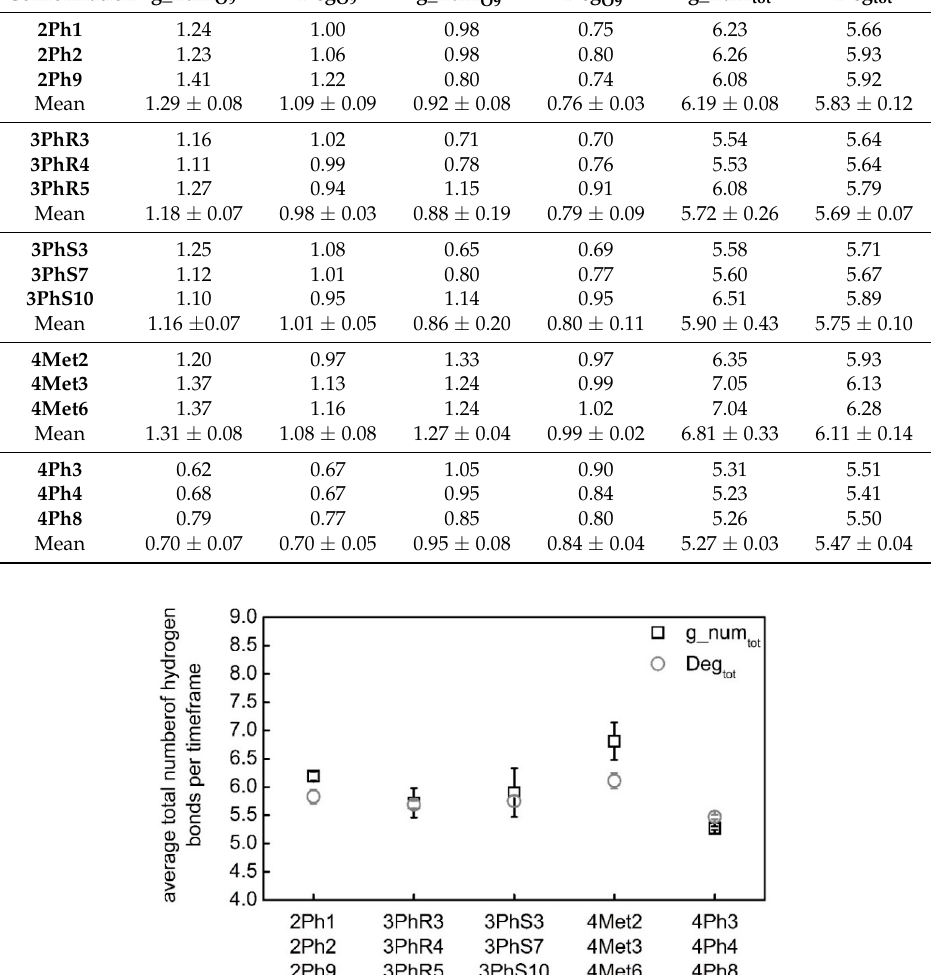
Table 2. The average number of hydrogen bonds per timeframe (Gromacs) compared to the average hydrogen bond degree between TIP4P water and the sites of interest in the LIGNOLs ( ChemNetworks = CNw).